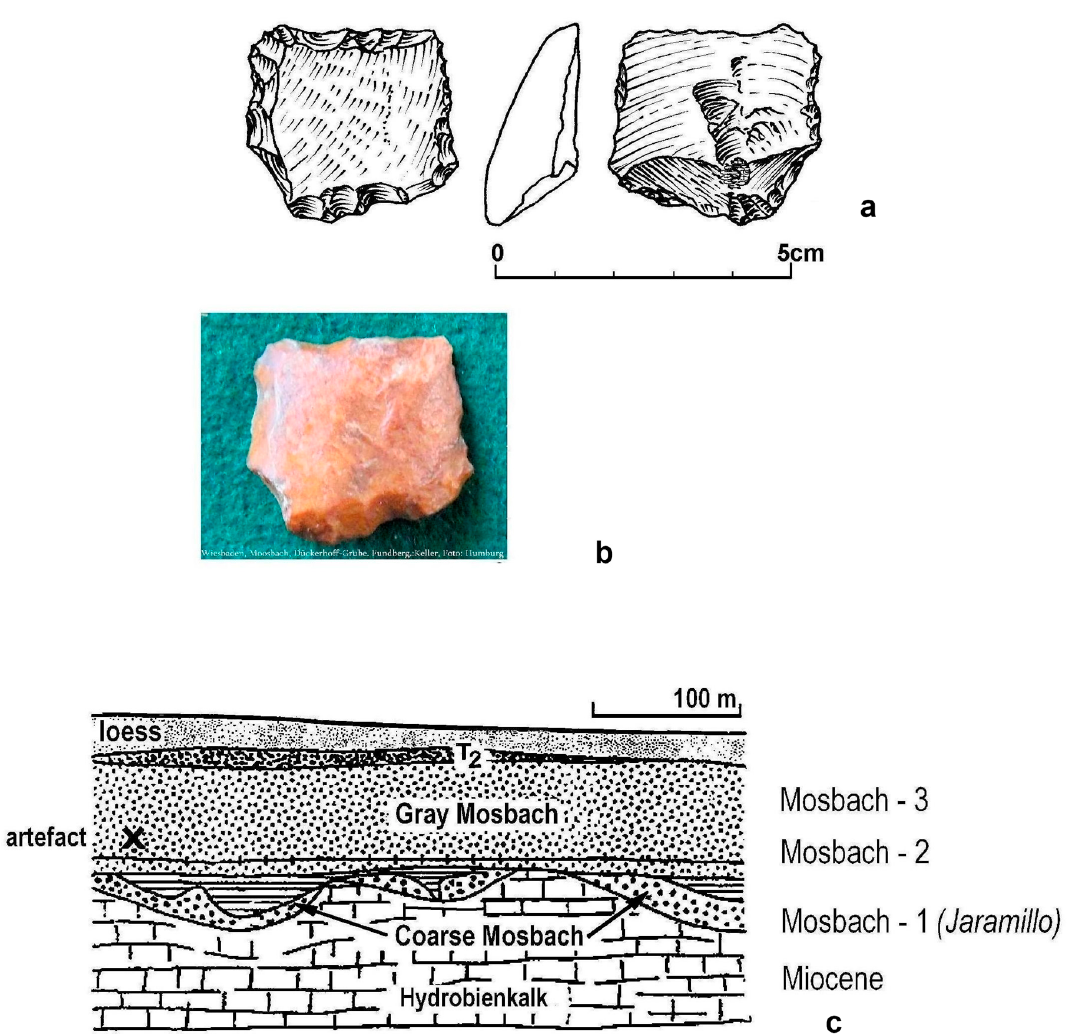
Figure 19. Mosbach (Wiesbaden). ( a , b ) Scraper (chert)—in situ out of the Middle Pleistocene level. ( c ) stratigraphy of the Mosbach Sands and the faunal stages. Mosbach 2 and 3 belong to the Brunhes period, while Mosbach 1 is clearly Matuyama/Jaramillo. (Drawing: L. Fiedler, N° 3 modified after Boenigk 1978, photo: C. Humburg.).